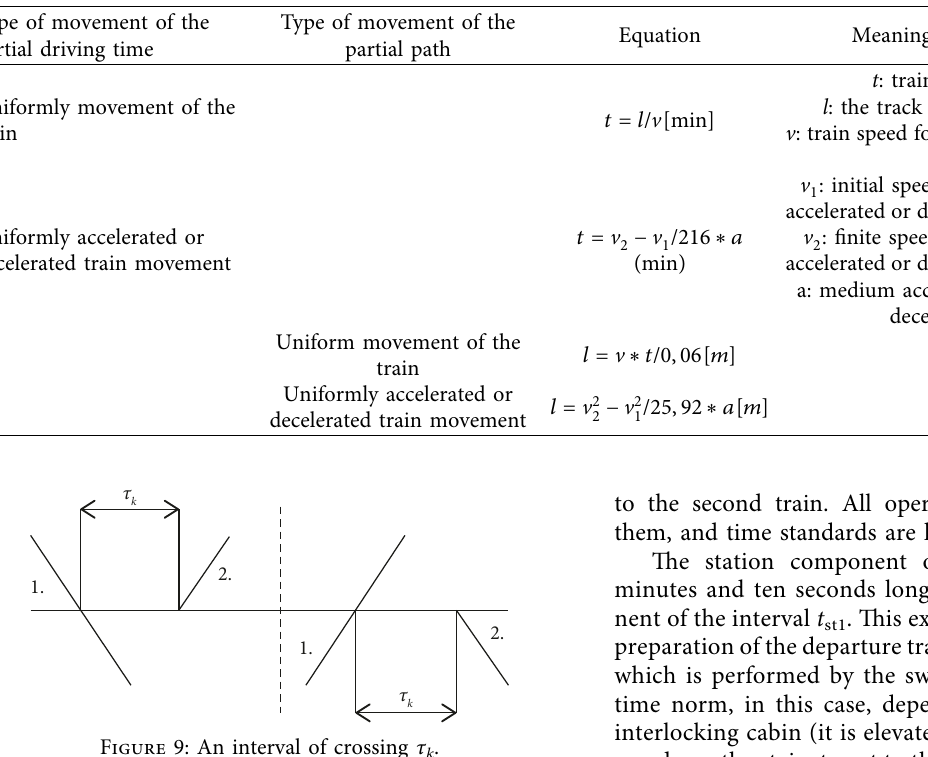
Table 4: Calculation of parts of dynamic component variants.